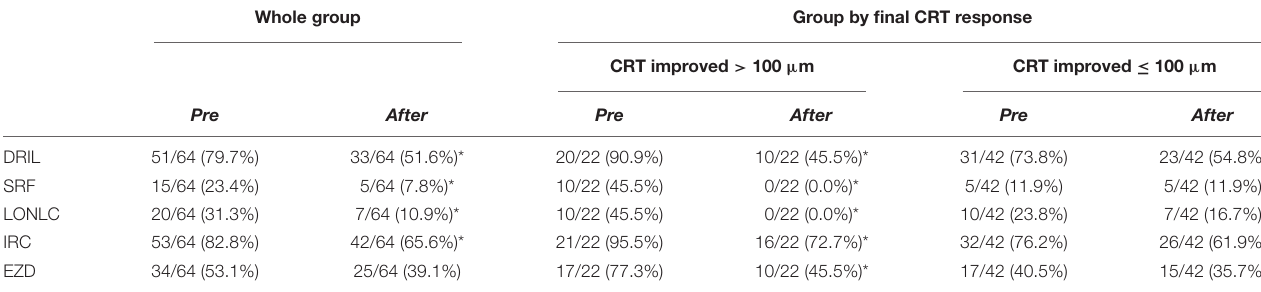
TABLE 5 | Changes of OCT biomarkers presentation pre (baseline) and after study in whole group and by final CRT response.